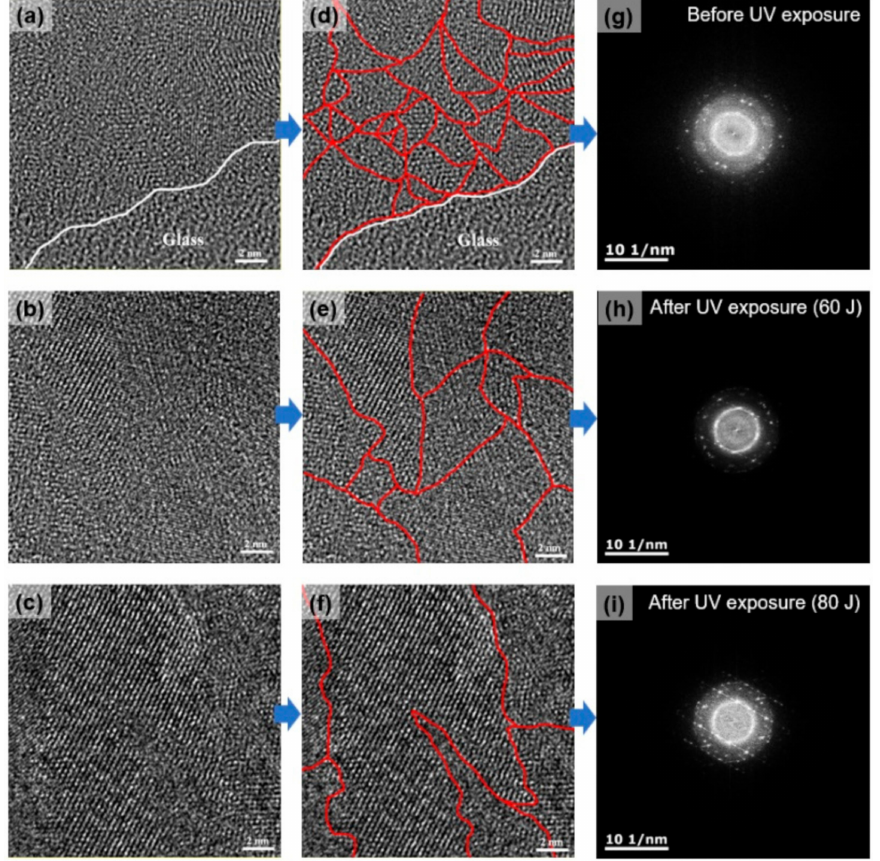
Figure 5. ( a – c ) HR-TEM image, ( d – f ) grain boundary indicated (red line) in the HR-TEM image, and ( g – i ) fast Fourier transform (FFT) pattern of as-deposited a-Si irradiated by UV lamp at 60 and 80